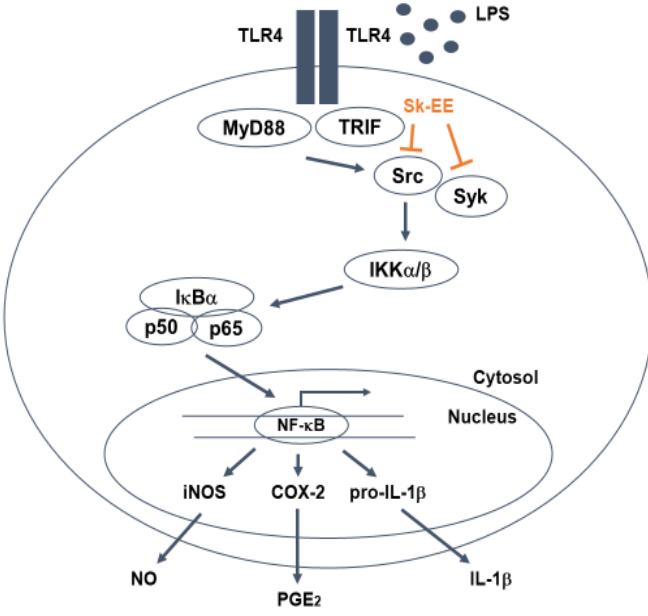
Figure 5. Schematic representation of overall signaling pathways and molecules targeted by Sk-EE during the inflammation process in macrophagelike cells.